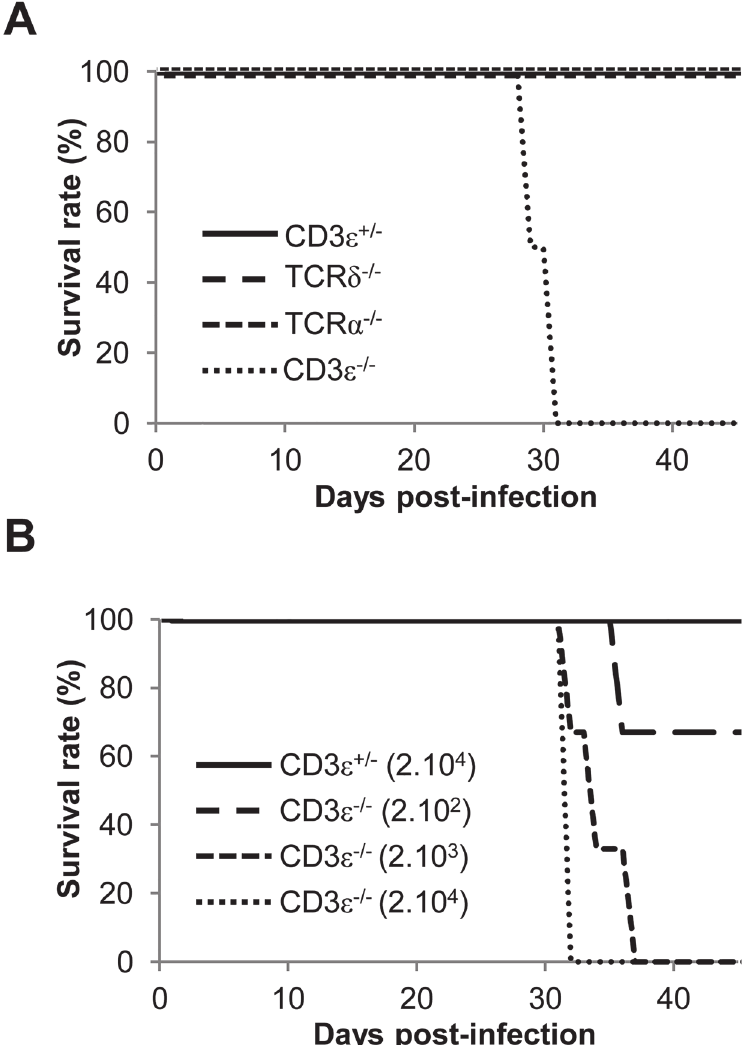
Fig 1. γδ T cells prevent mice from MCMV-induced mortality. A. TCR δ − / − , TCR α − / − CD3 ε +/ − and CD3 ε − / − mice (10 of each) were infected i.p. with 1.10 5 PFU of MCMV at day 0 and monitored every other day for mortality. Data are from one representative of 3 independent experiments. B. CD3 ε +/ − and CD3 ε − / − mice (4 of each) were infected i.p. with indicated doses of MCMV at day 0 and monitored every day for mortality. Data are from one